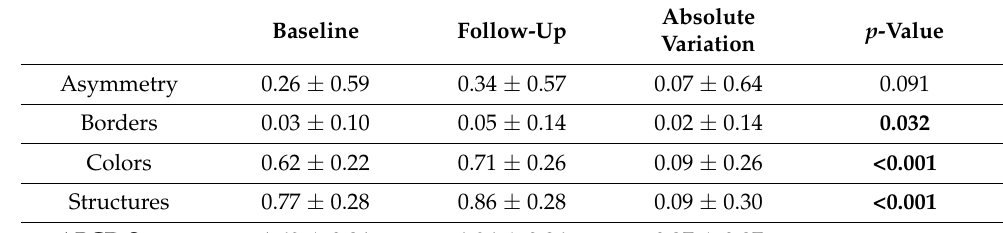
Table 3. Mean and standard deviation (SD) of 222 nevi analyzed.